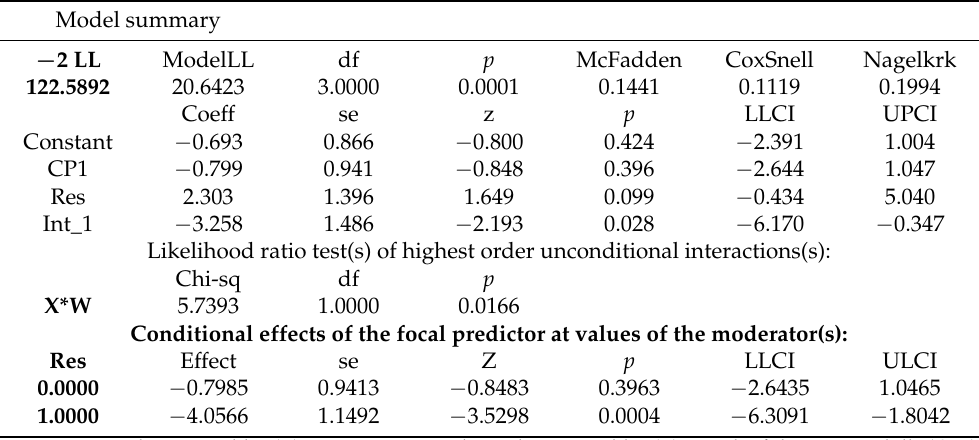
Table 7. Testing the moderating effect of resilience in the coping